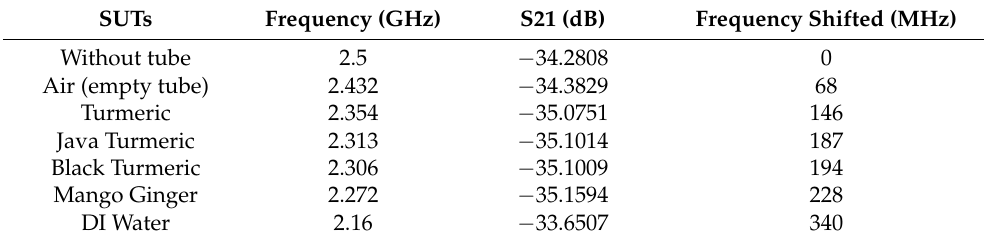
Table 3. Simulation datasets of triple-rings CSRR design with several